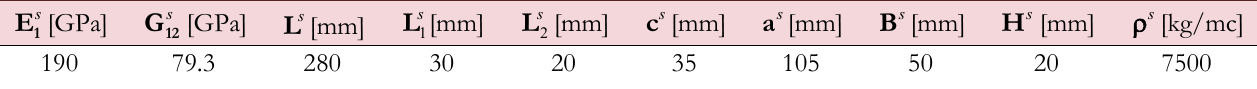
Table 3: Geometrical and mechanical properties of the steel beam.